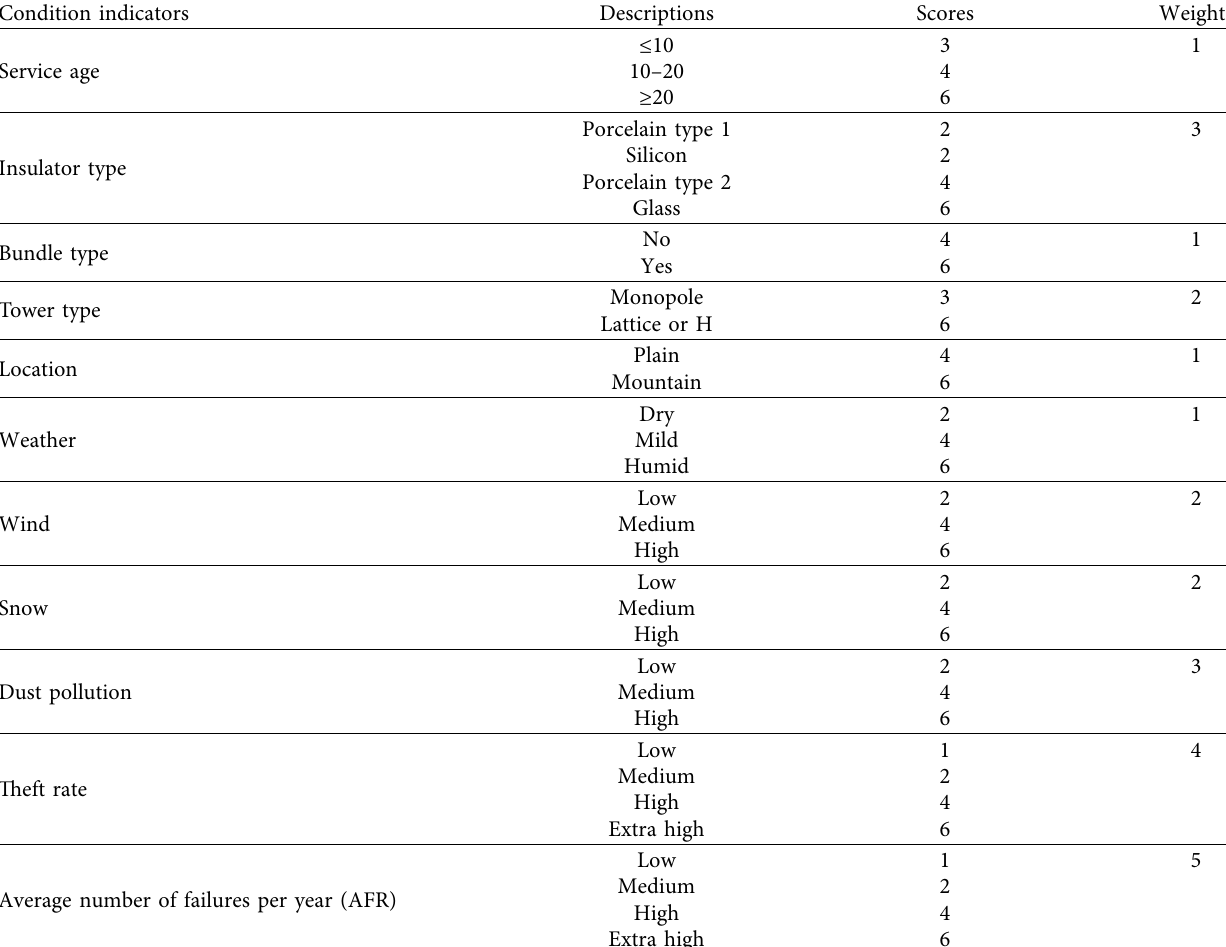
Table 1: Scores and weighting factors of condition indicators for determining the line condition